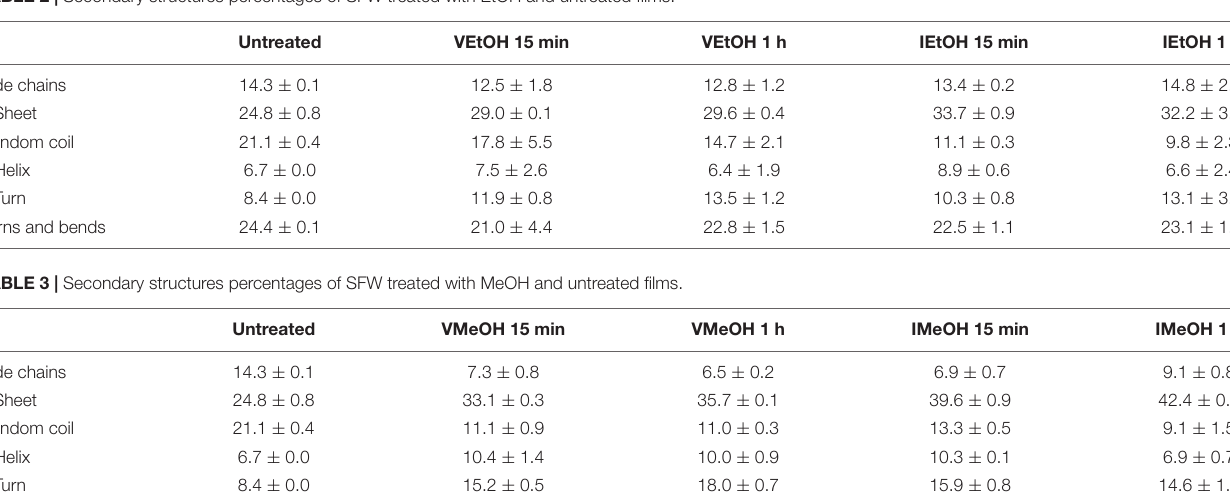
TABLE 2 | Secondary structures percentages of SFW treated with EtOH and untreated films.